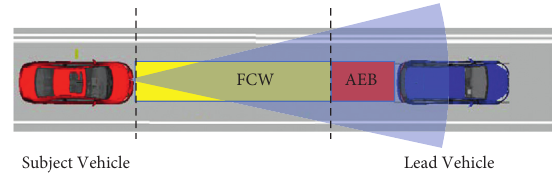
Figure 1: The FCW and AEB crash avoidance systems for car- following